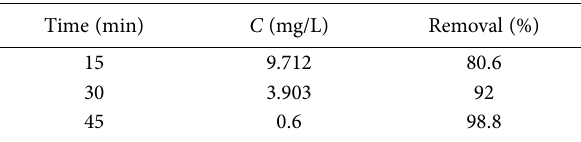
Table 5. Ion flotation results for 100mL solutions of 50mg/L (7.87 × 10 -4 M) copper using crystallised N-octanoyl-cys surfactant with